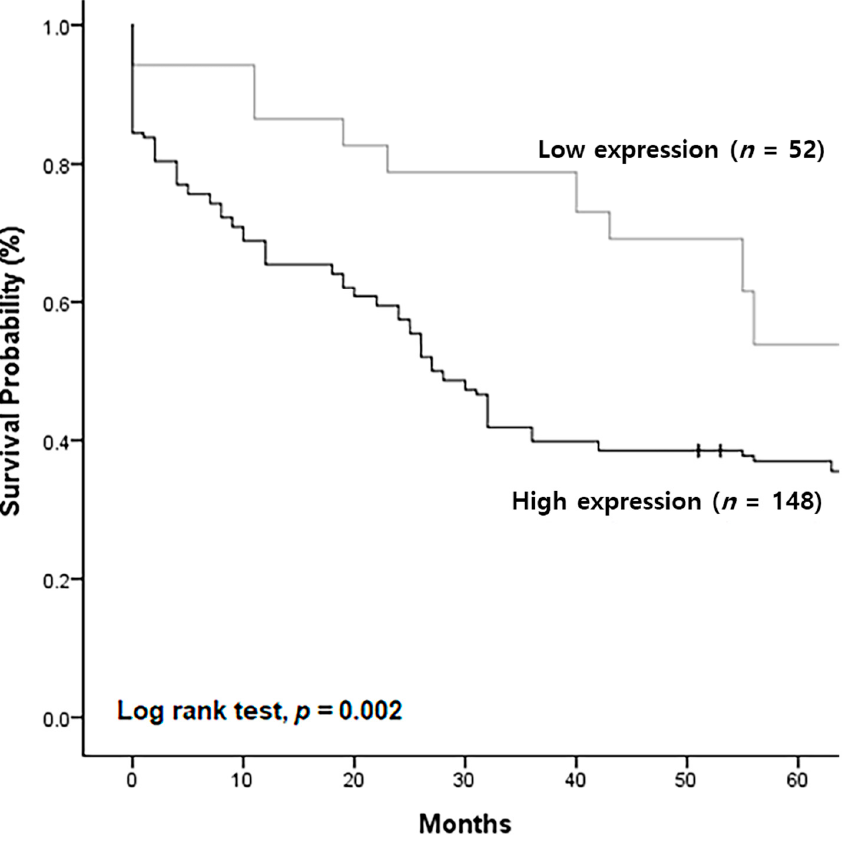
Figure 7. Changes in patient survival rate according to TSPAN5 expression level expressed by the Kaplan–Meier graph.